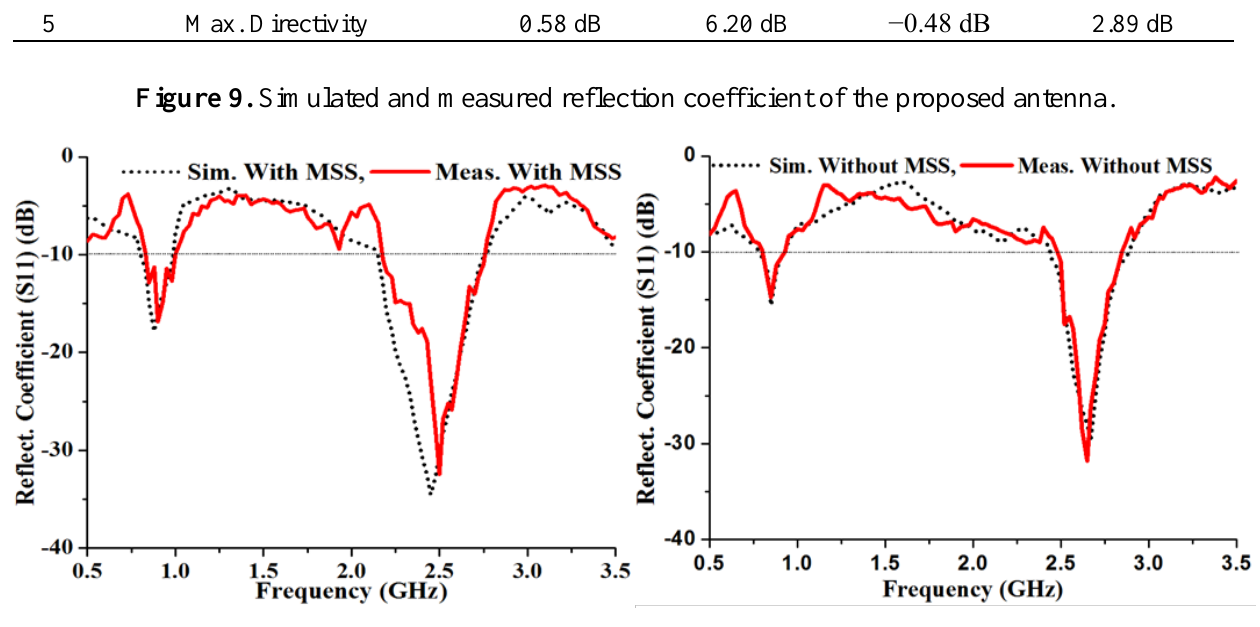
Figure 10. Gain and directivity of the proposed antenna with MSS and without